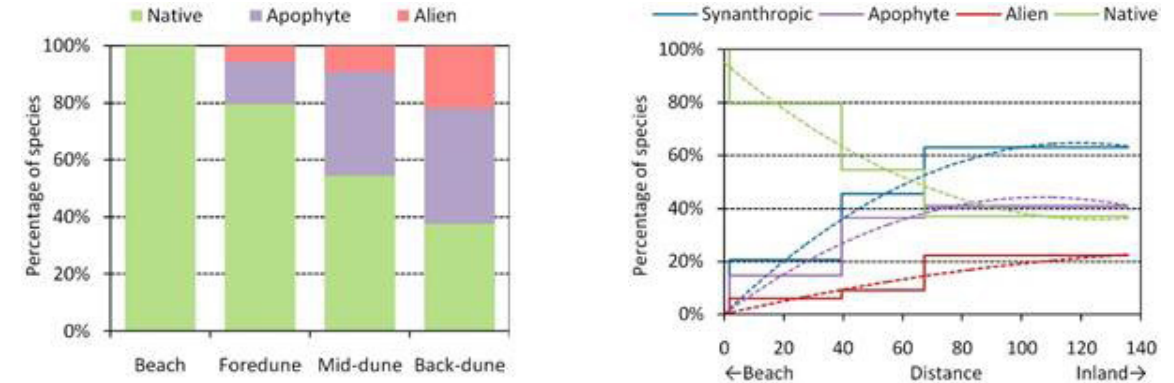
Figure 4. Synanthropisation of the main habitats. Left: Percentages of species per category and habitat. Right: Changes of plant categories related to beach distance.